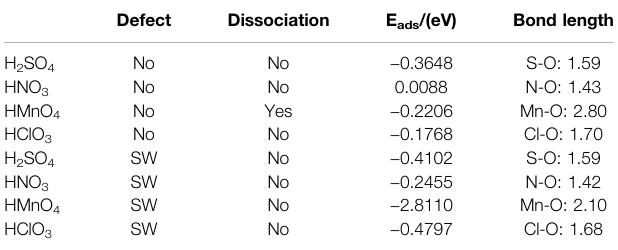
TABLE 1 | Reaction of single component on the surface of graphene without water. Defect Dissociation E ads /(eV) Bond length